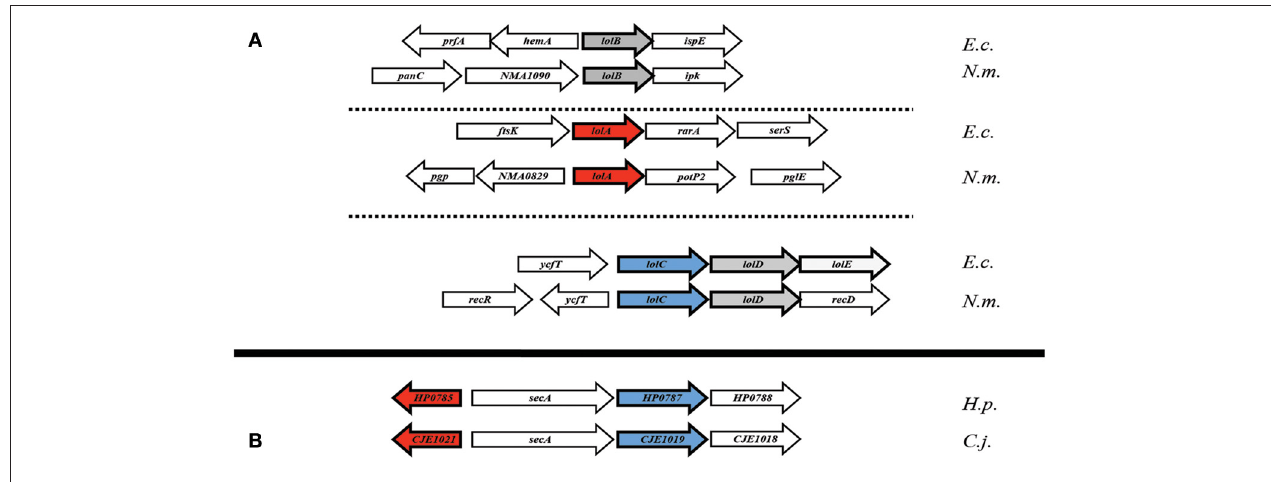
FIGURE 3 | Genetic orientation of Lol complex-homologs. (A) Lol complex associated loci ( lolA and lolB , specifically) from E. coli and N. meningitidis appear spread throughout the genome (B) while complex-homologs from H. pylori and C. jejuni appear to be clustered around